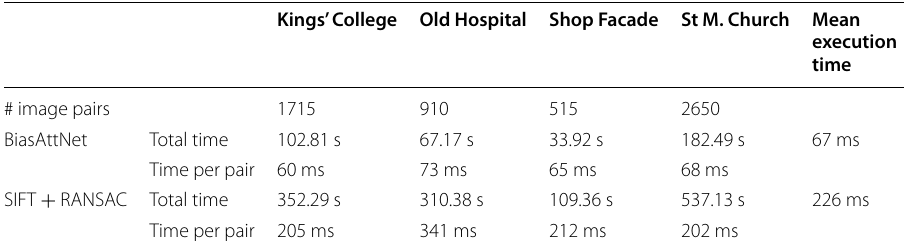
Table 5 Execution time of our localization